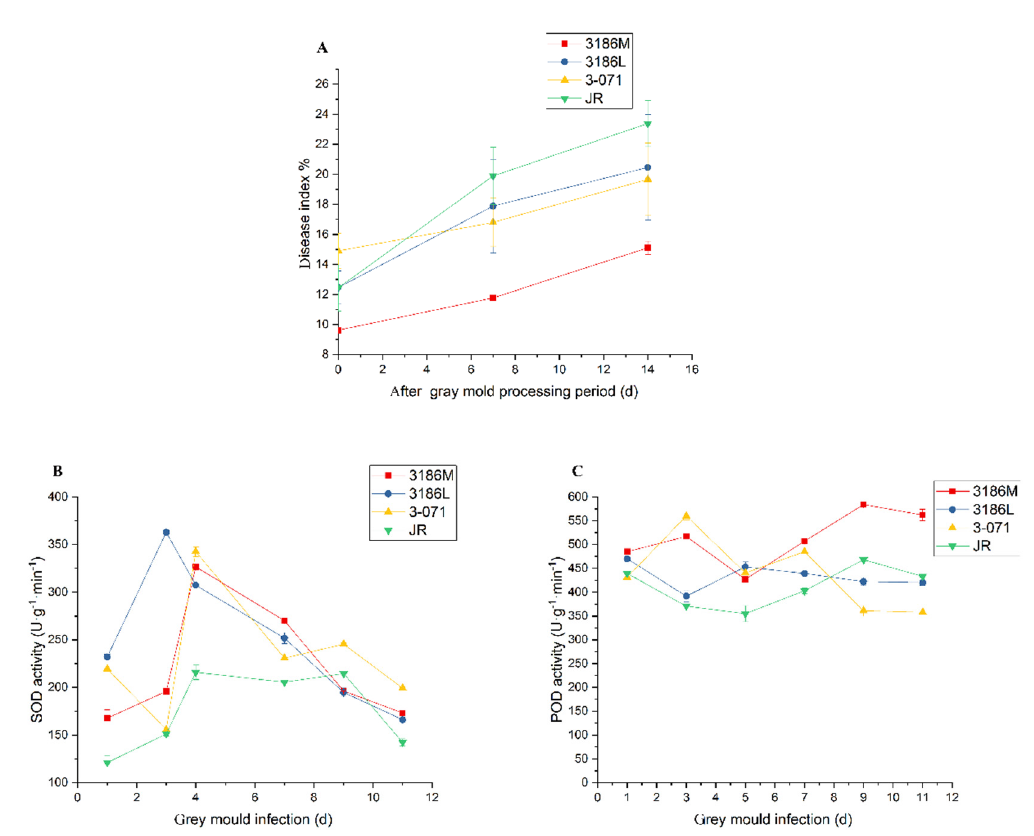
Table 2. Chlorophyll content of tomato accession seedlings in the six-leaf stage when treated with Botrytis cinerea. Among them, a and b represent different degrees of chlorophyll content. The values represent the average of three technical replicates ± SD. 3186M (tomato wo mutant , hairy), 3186L (tomato wo mutant , hairless), 3-071 (tomato ln mutant , hairless), JR (tomato cultivar Jia Ren).